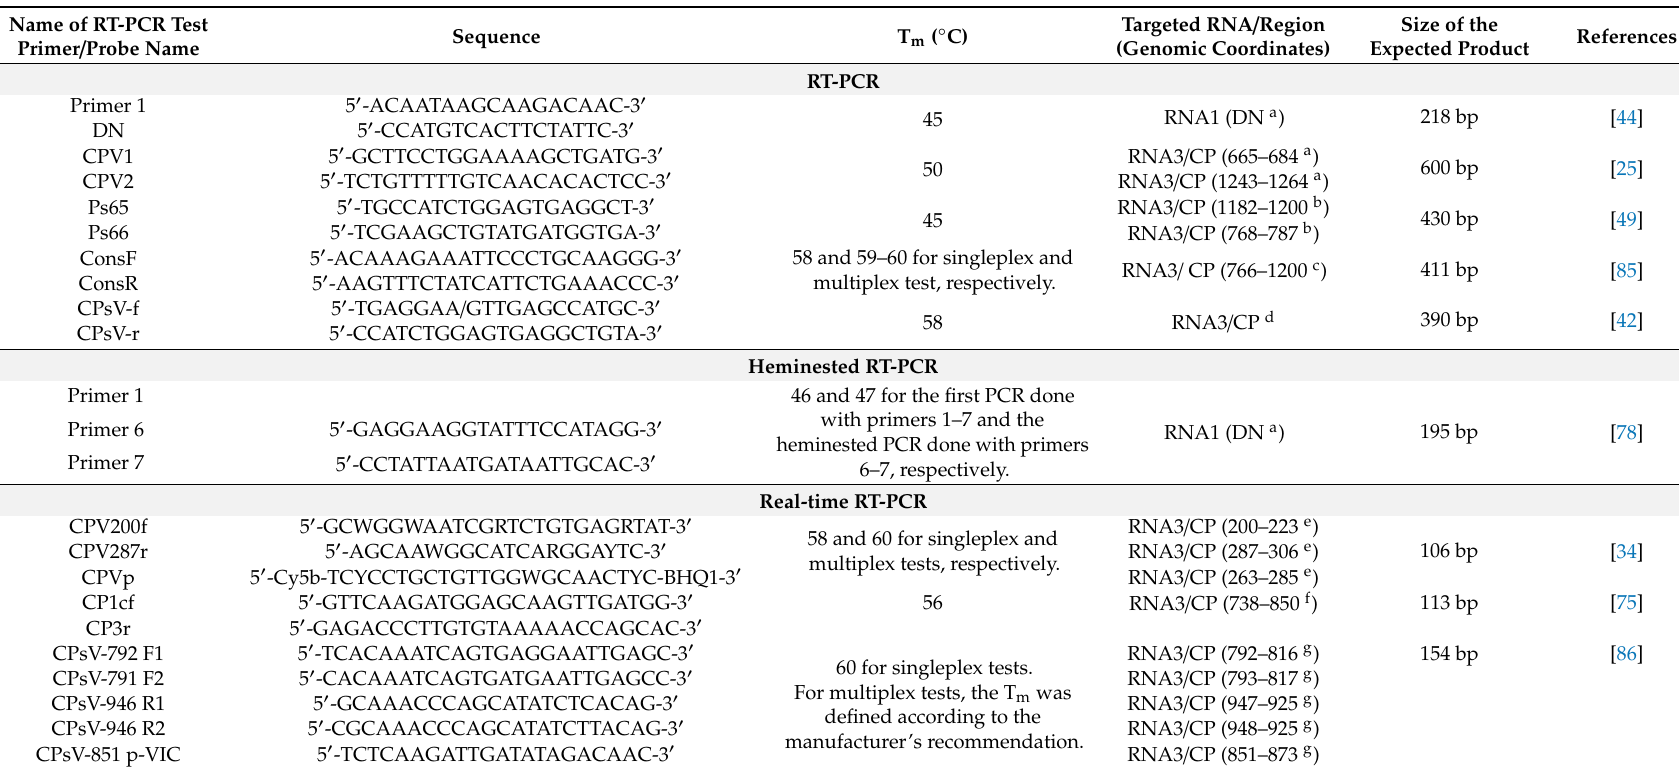
Table 2. Primer sequences and their annealing temperature (T m ), primer / probe location, and expected size of PCR products for each primer pair when used to amplify CPsV by RT-PCR and related